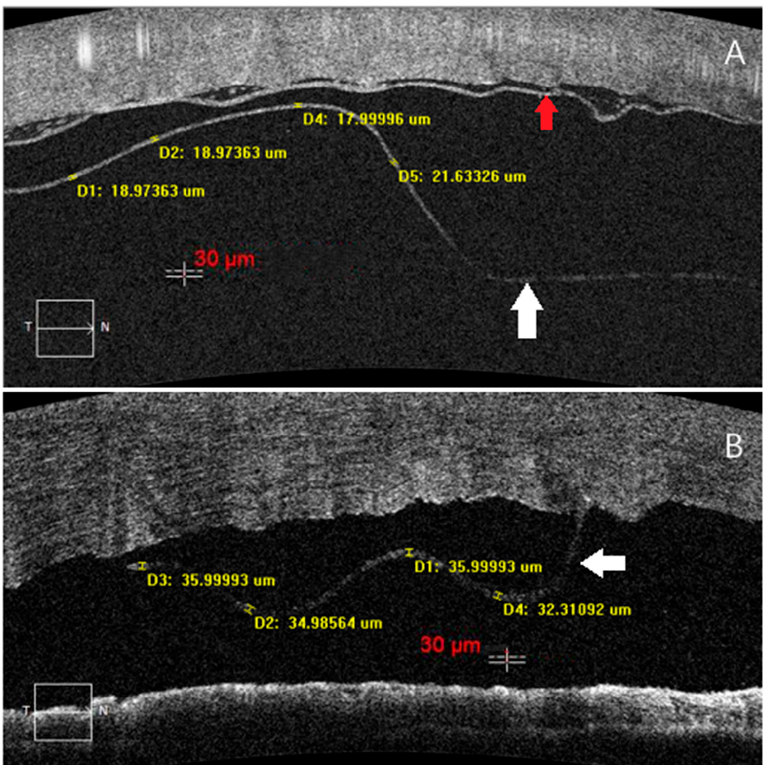
Figure 3. ( A ): One case of a 25-year-old male with cornea leukoma in his right eye, who underwent pdDALK with little residual stroma was left behind, the EDM layer (white arrow) was observed separated from the residual stroma bed (red arrow) by HD-OCT on the first post-operative day, and it’s the thinnest EDM in all subjects. ( B ): One case of a 53-year-old male with bacterial keratitis in his right eye, who underwent PKP (the donor age was 75 years), the EDM layer was observed partial separated from stroma by HD-OCT on the first post-operative day, and it was the thickest EDM in all of the subjects.